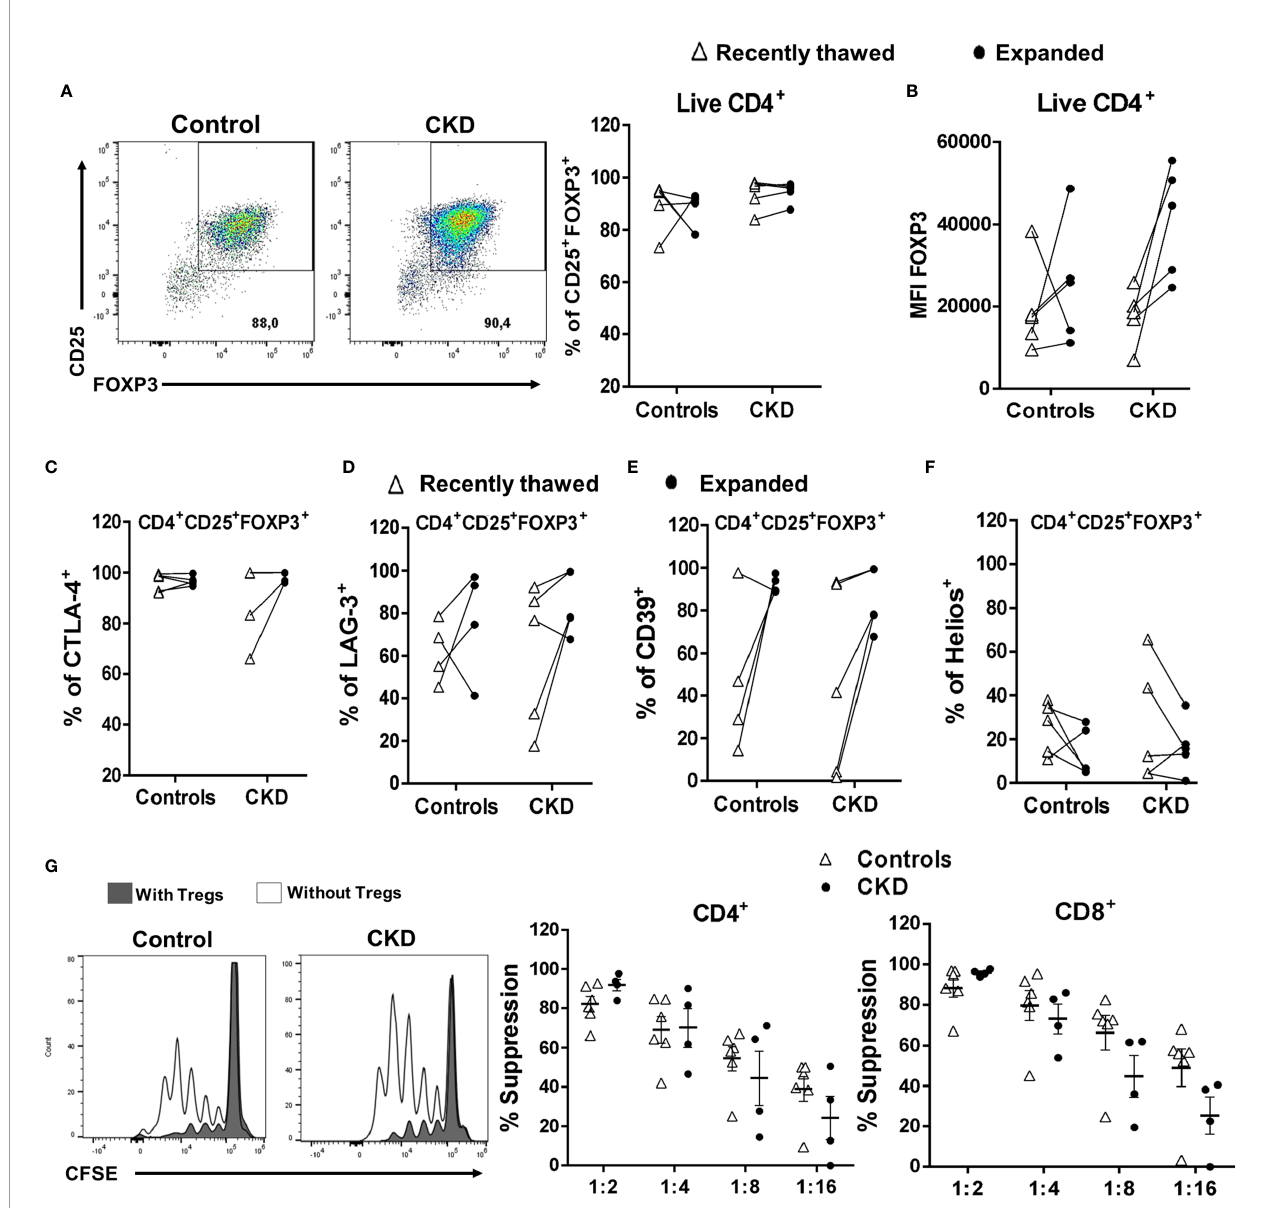
FIGURE 8 | Expanded regulatory T cells (Tregs) maintained their phenotype and in vitro function after long-term cryopreservation. On day 28 of polyclonal expansion, alloantigen-speci fi c Tregs ( allo Tregs) from healthy individuals ( white triangles , n = 4) or patients with chronic kidney disease (CKD) ( black circles , n = 4) were cryopreserved for a long time (>6 months), and then the cells were thawed and polyclonally expanded. The expressions of the Tregs markers and their in vitro immunosuppressive function were determined by fl ow cytometry. (A – F) After 2 weeks of stimulation, thawed allo Tregs from both groups maintained the proportions of CD25 + FOXP3 + (A) , CTLA-4 + (C) , LAG-3 + (D) , and CD39 + (E) cells and the expression of FOXP3 (B) , but a low proportion of Helios + cells (F) . (G) Cryopreserved allospeci fi c Tregs can suppress the proliferation of both polyclonal CD4 + ( left ) and CD8 + ( right ) T cells after 2 weeks of expansion. Representative experiments are shown in (A, G) . The results are shown as the mean ± SEM. Statistical analysis was performed using the Mann – Whitney U test or Wilcoxon test. No signi fi cant differences were